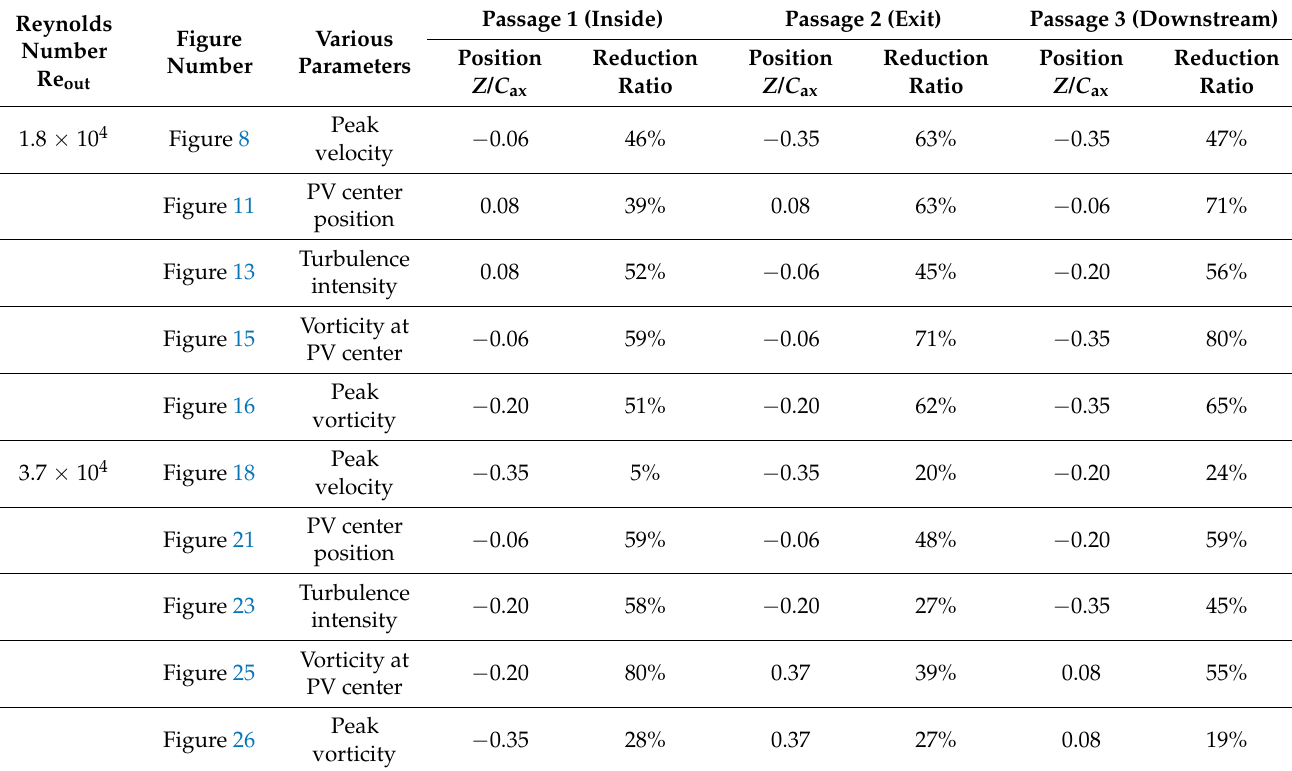
Table 4. Summary of the maximum reduction in various parameters.